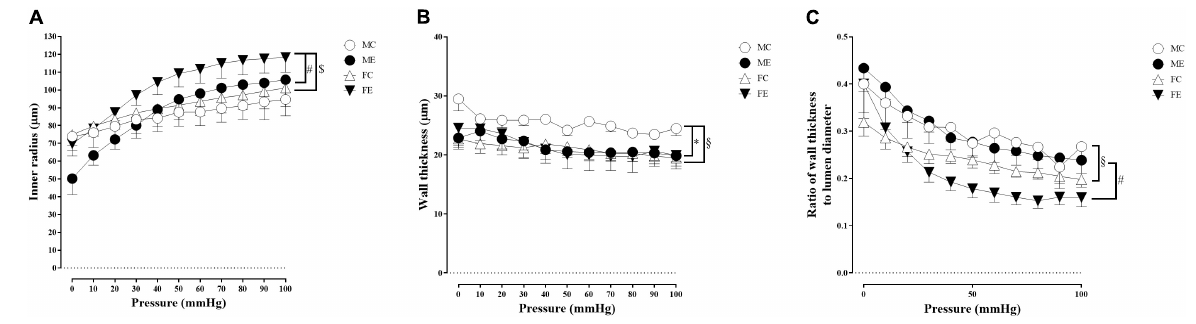
Frontiers in Physiology |